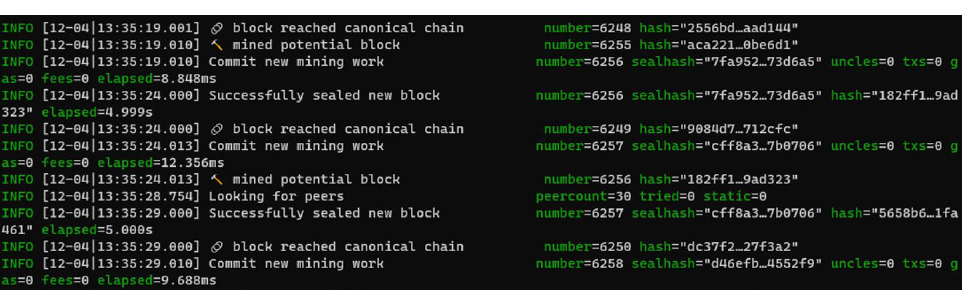
Figure 9. Node syncing.